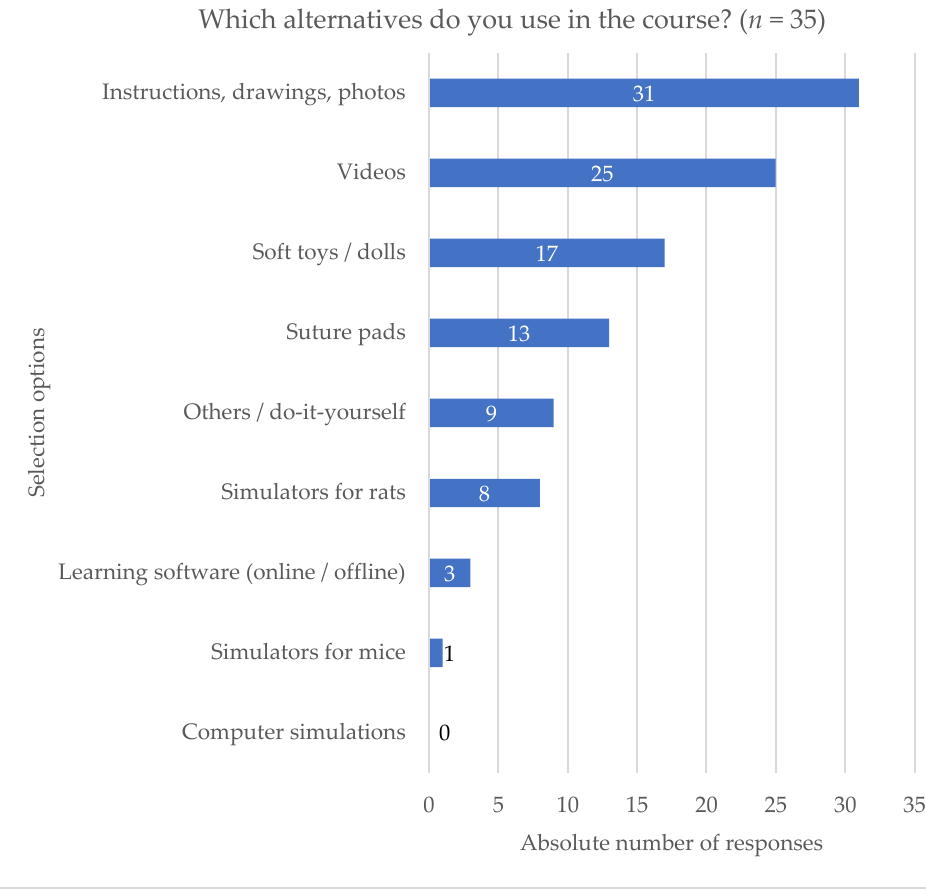
Figure 1. Descriptive analysis of the use of alternatives in training courses. Distribution of replies concerning the type of alternatives used in the most frequently performed course type derived from the multiple-choice question “Which alternatives do you use in the course?”. Absolute number of responses is shown for each respective method ( n = 35).